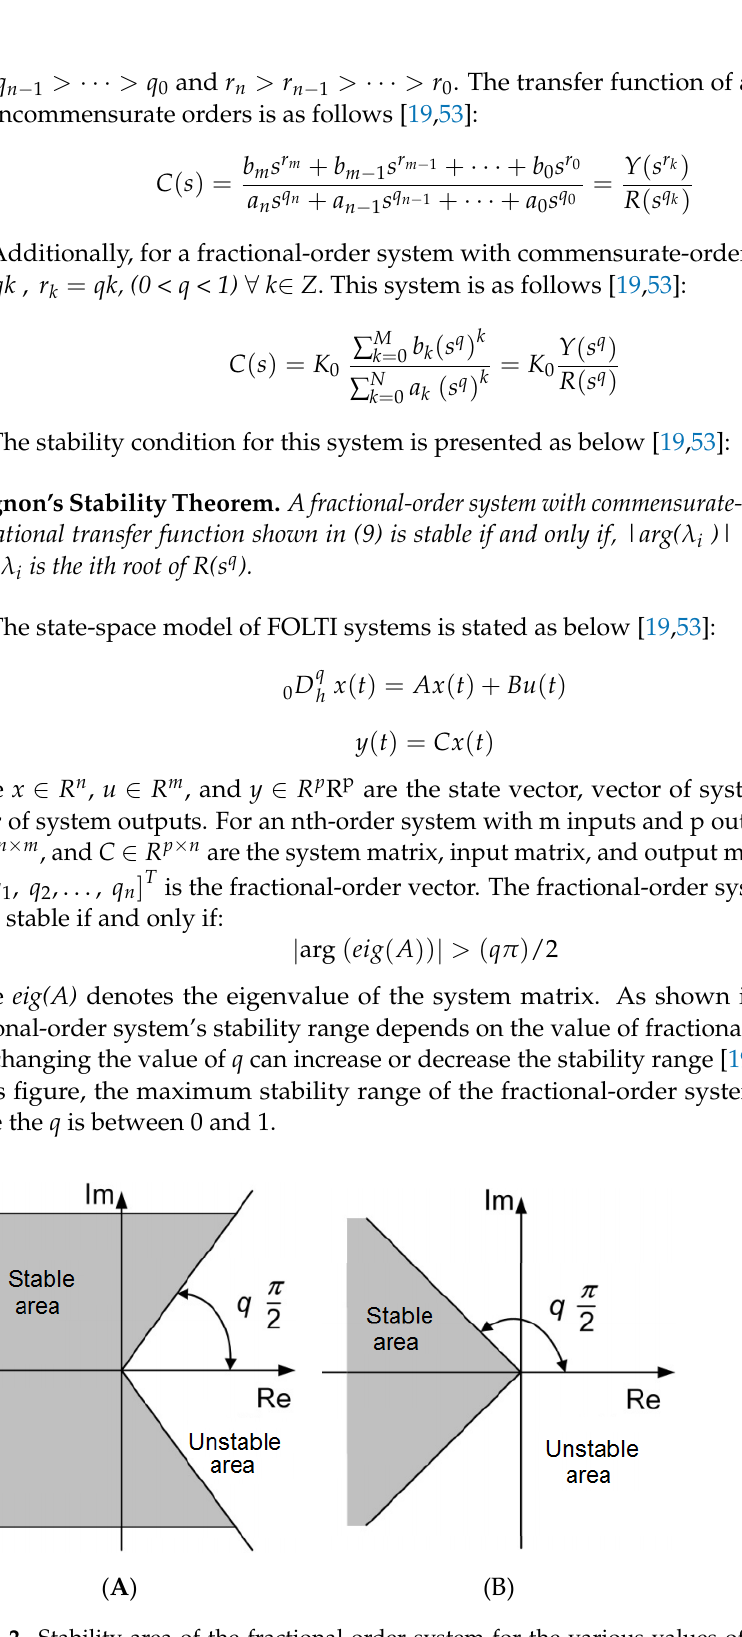
Figure 2. Stability area of the fractional-order system for the various values of q : ( A ) 0 < q < 1; ( B ) 1 < q < 2.